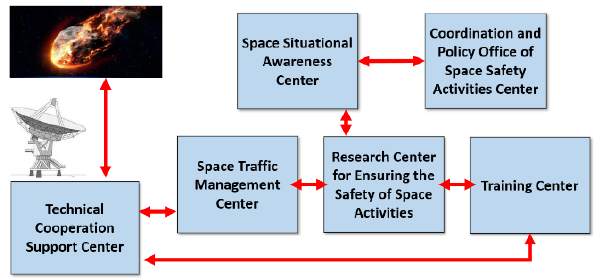
Figure 7. The diagram of the interaction of the main centers of the NSS system in the event of a dangerous